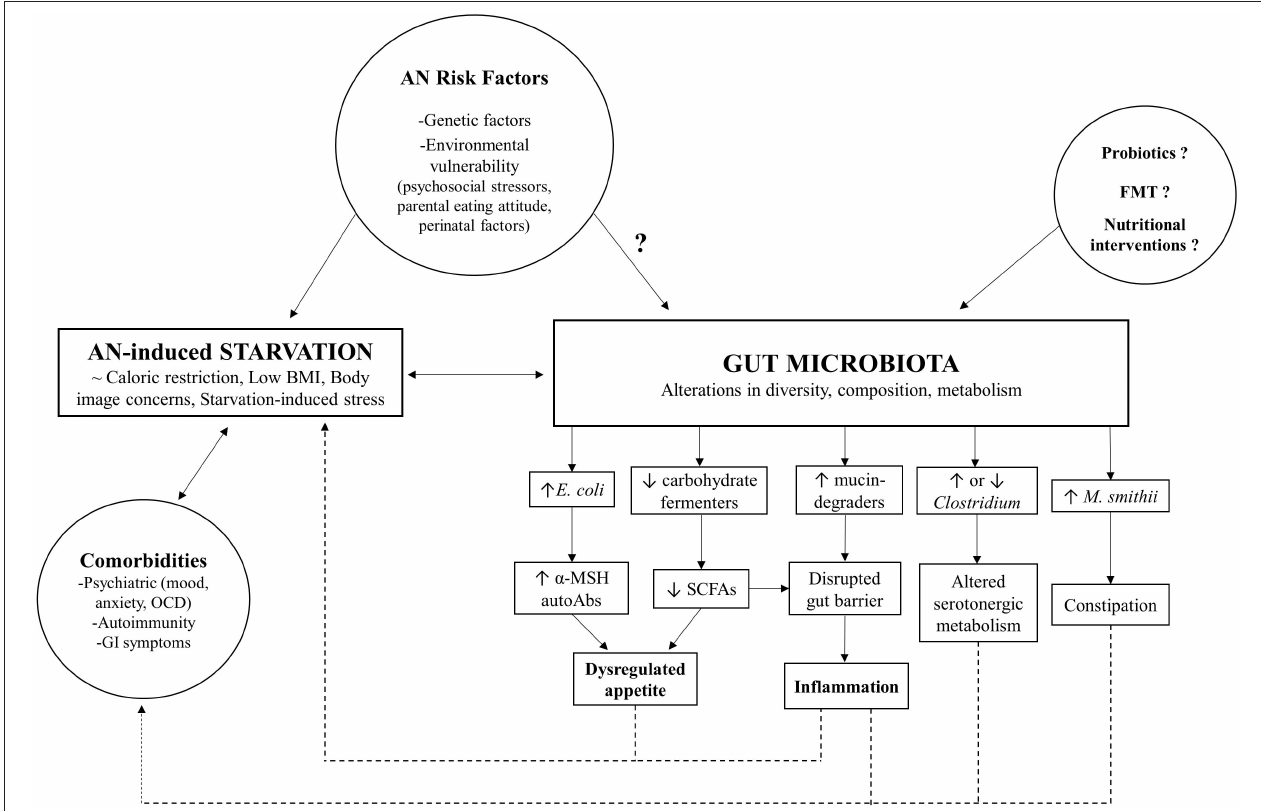
FIGURE 1 | Model for gut microbiome involvement in AN pathophysiology.